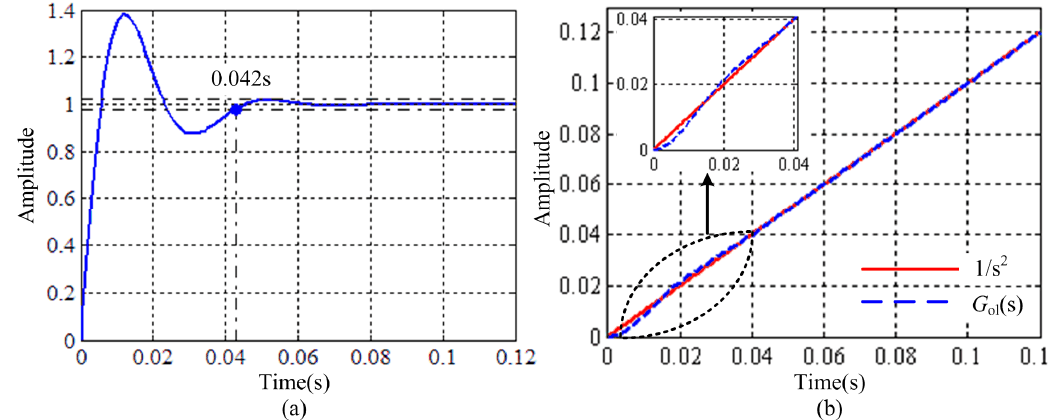
Figure 10. Transient response of closed-loop transfer function for h = 2.5. ( a ) The unit step response; ( b ) The unit impulse response.